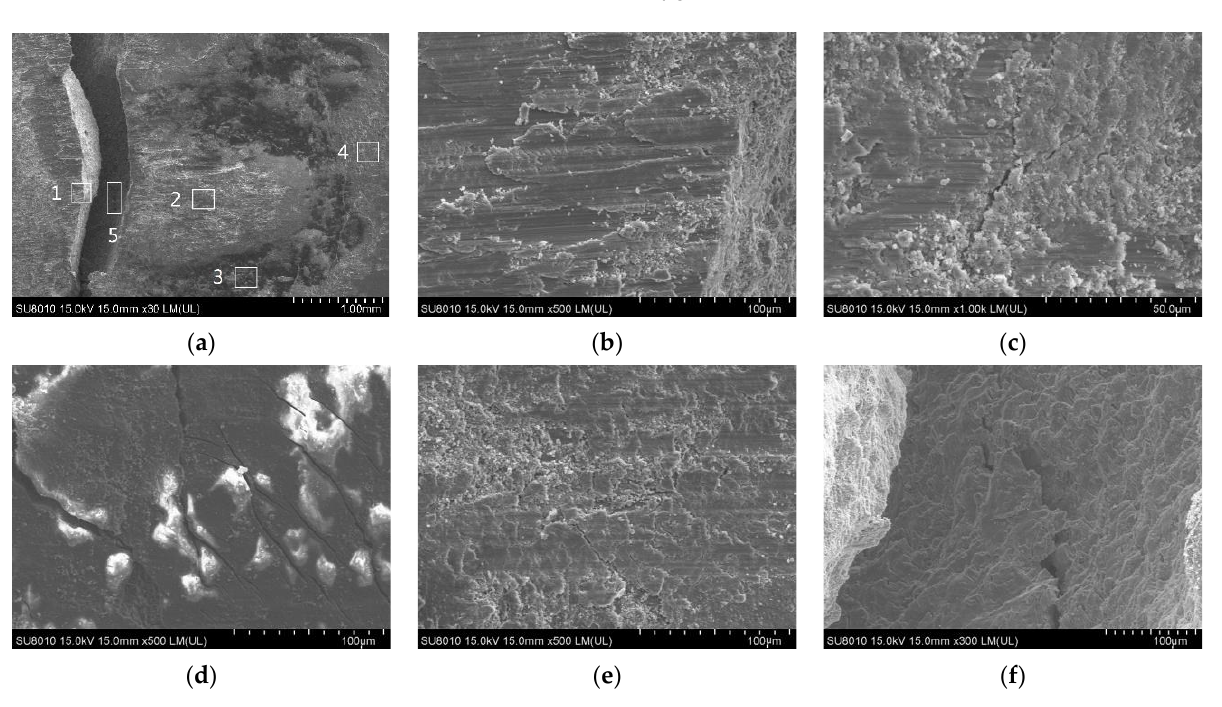
Figure 13. Fatigue wear surface of AA5052 sheet: ( a ) Morphology of fatigue fracture (The locations marked by 1,2,3,4,5 are enlarged in subfigure ( b – f )); ( b ) Fracture morphology of zone 1; ( c ) Fracture morphology of zone 2; ( d ) Fracture morphology of zone 3; ( e ) Fracture morphology of zone 4; ( f ) Fracture morphology of zone 5.